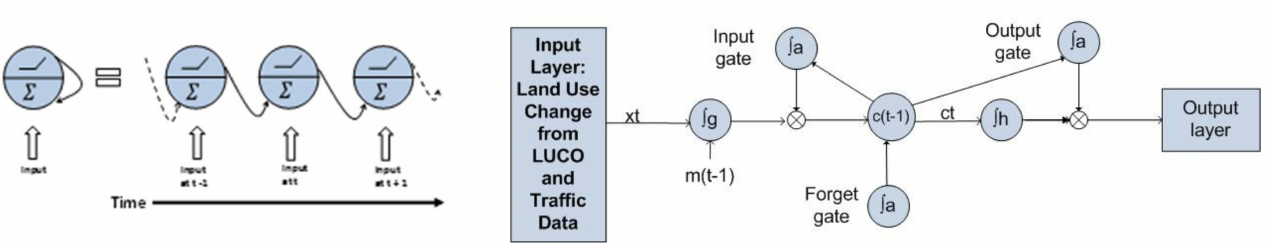
Figure 7. RNN overall concept ( left ) and proposed RNN (RNN-LSTM) ( right